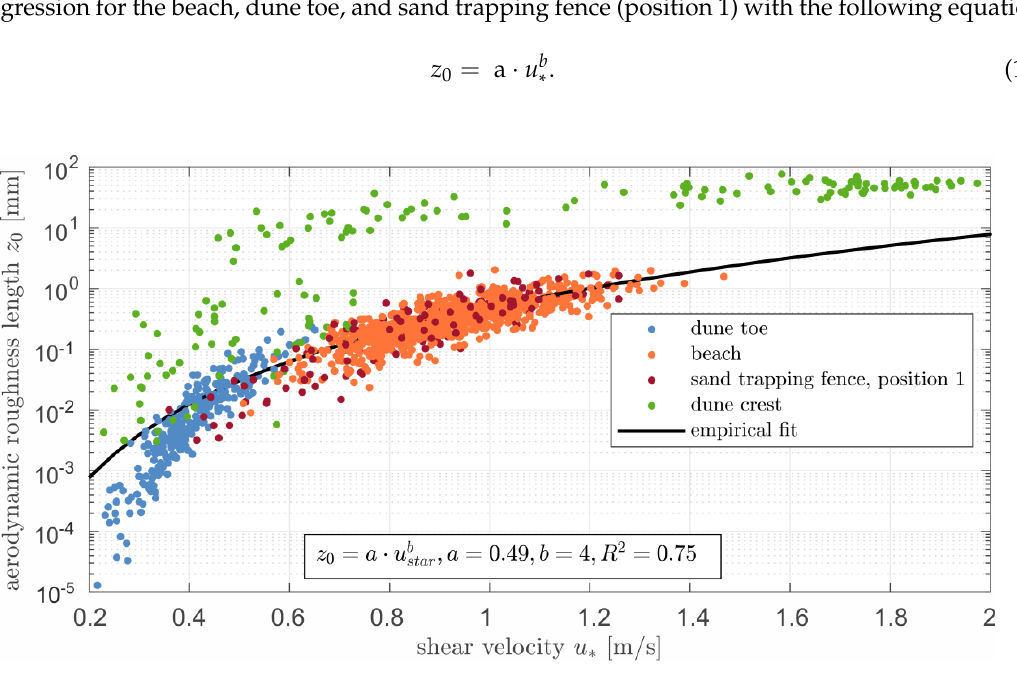
Figure 9. Regression line for the calculated shear velocity and aerodynamic roughness length for the measurement locations of the dune toe, beach, and sand trapping fence (position 1) and calculated aerodynamic roughness length for the location dune crest (not part of the